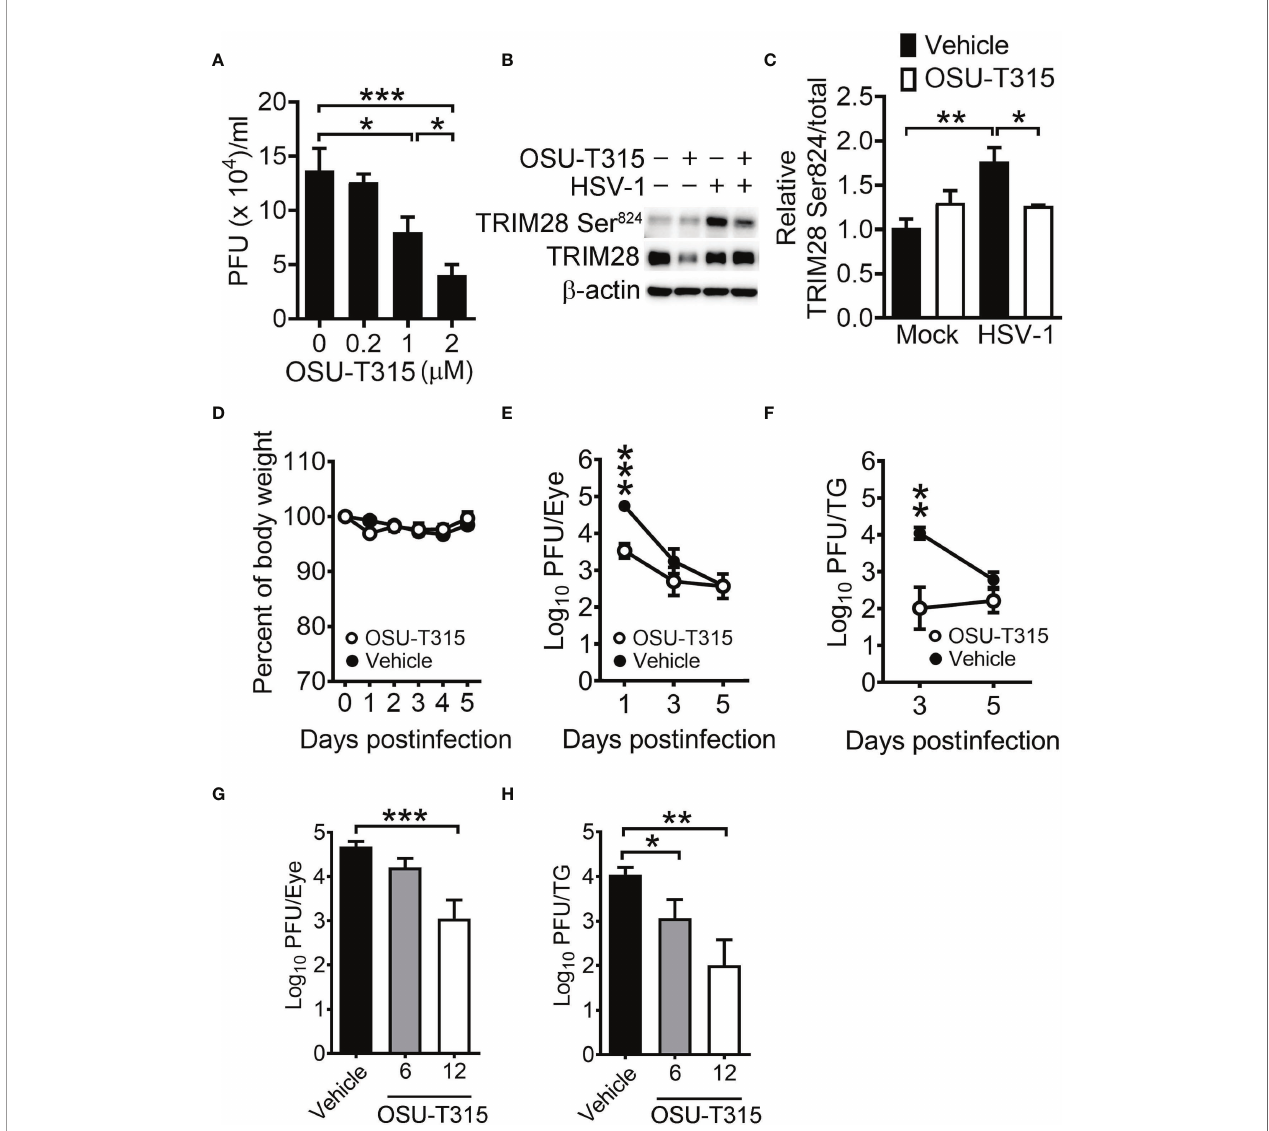
FIGURE 7 | ILK inhibitor reduces HSV-1 replication in cells and mice. (A) The viral yields at 24 hours postinfection in SK-N-SH cells infected with HSV-1 (MOI = 0.01) and treated with the indicated concentration of OSU-T315 one hour after infection are shown. (B, C) The representative western blots (B) and relative levels (C) of indicated proteins at 3 hours postinfection in mock- (-) or HSV-1-infected (+) cells (MOI = 1) treated with vehicle (-) or 2 µM OSU-T315 (+) are shown. The level of TRIM28 Ser 824 normalized to TRIM28 in mock-infected cells treated with vehicle was set as 1. (D – F) C57BL/6J mice were infected with 2 × 10 5 PFU of KOS and treated with vehicle (n = 7) or 12 mg/kg OSU-T315 (n = 7). The relative body weight (D) and HSV-1 titers in the eyes (E) and trigeminal ganglia (TG; F ) are shown. The body weight of mice on the day of infection was set as 1. (G, H) The HSV-1 titers in the eyes on 1 day postinfection (G) and trigeminal ganglia on 3 days postinfection (H) of infected mice treated with vehicle (n = 4) or the indicated concentration of OSU-T315 (n = 5 in each group) are shown. Data represent mean ± or + SEM (error bar). * p < 0.05, ** p < 0.01, *** p < 0.001 via Student t test in panel C and Mann-Whiteny U test in the rest